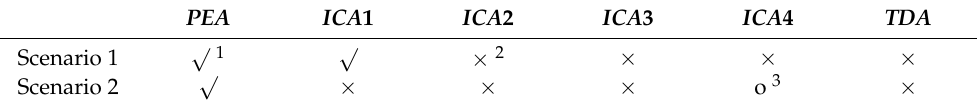
Table 5. Two special scenarios for the PC related load disaggregation.